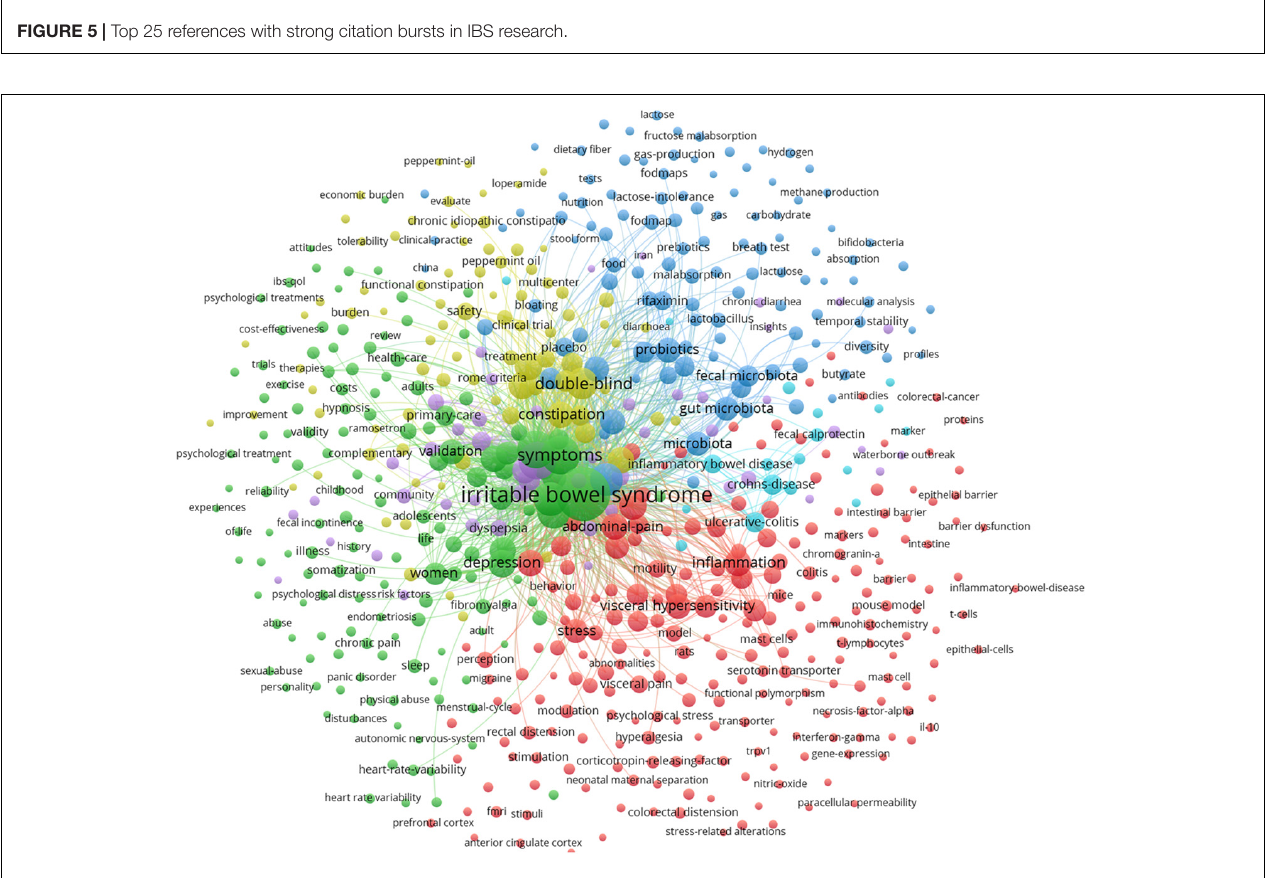
FIGURE 6 | Map of keyword clustering with a minimum of 5 occurrences in